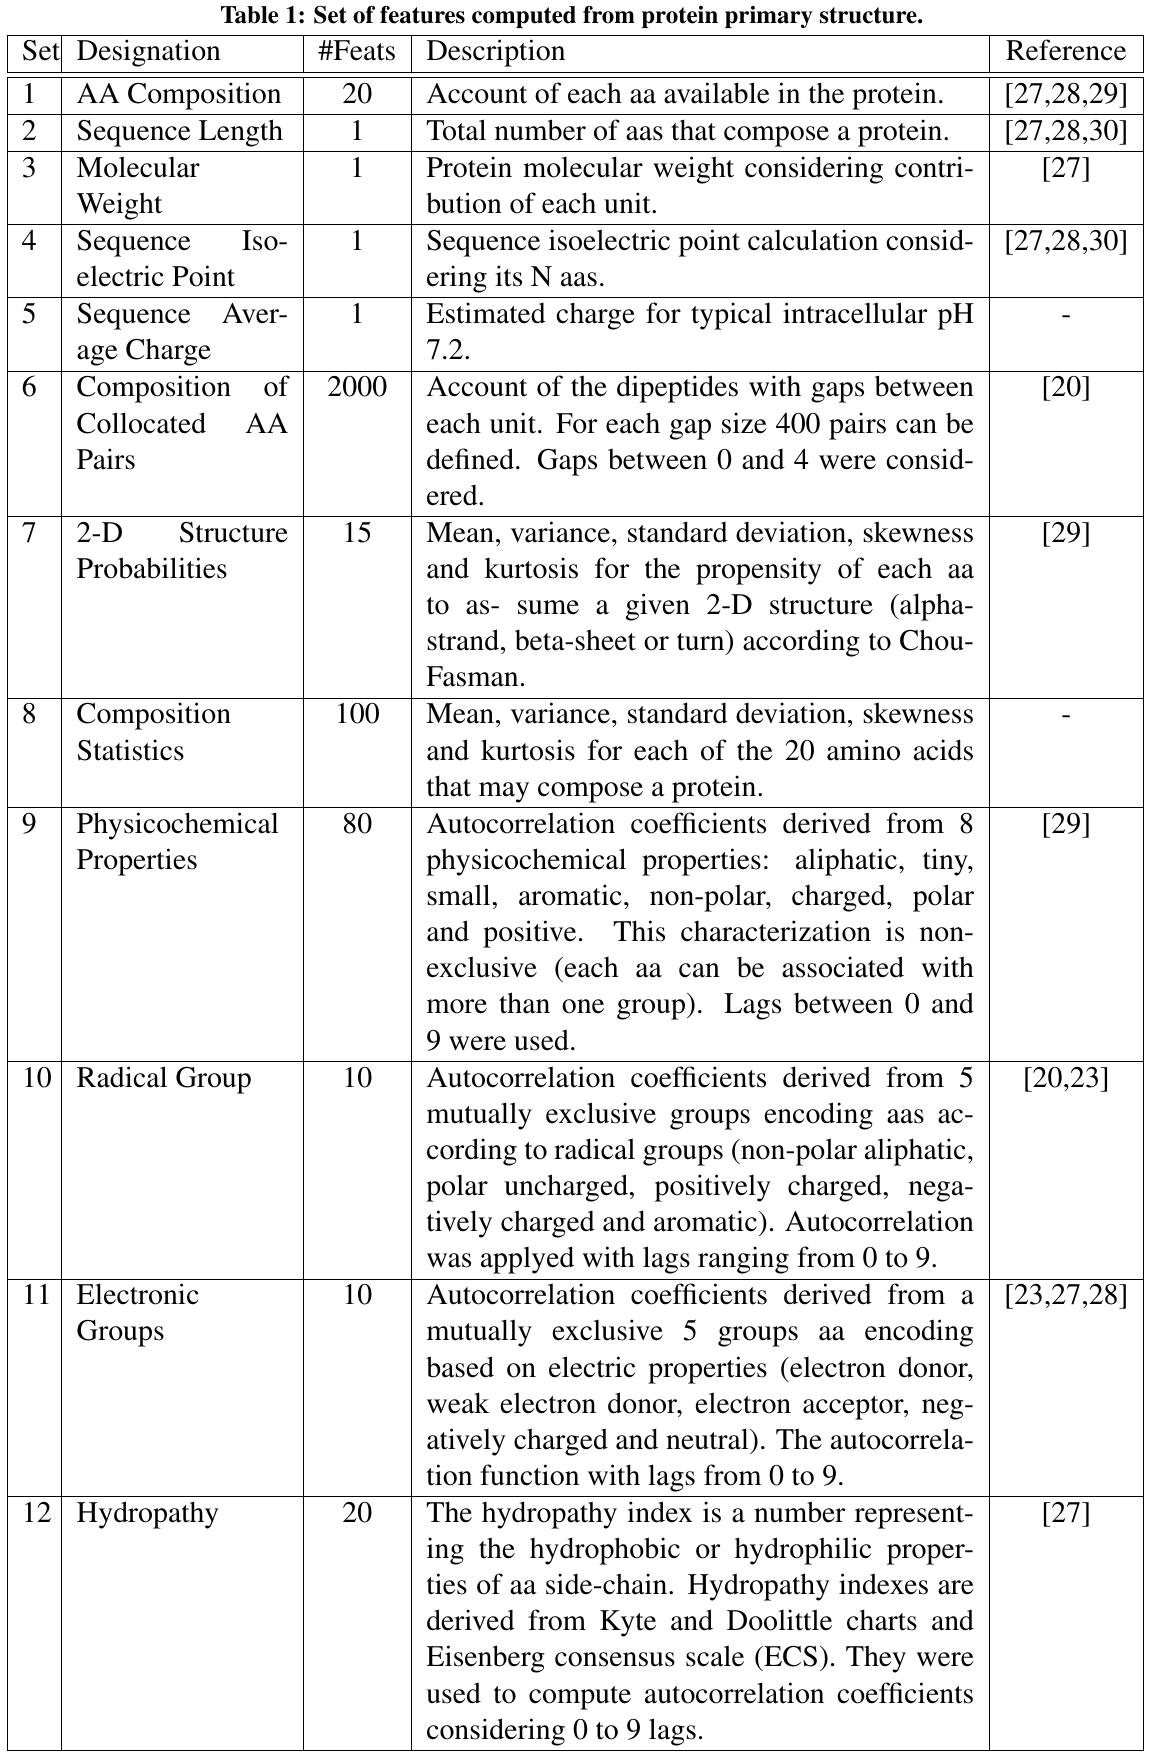
Table 1: Set of features computed from protein primary